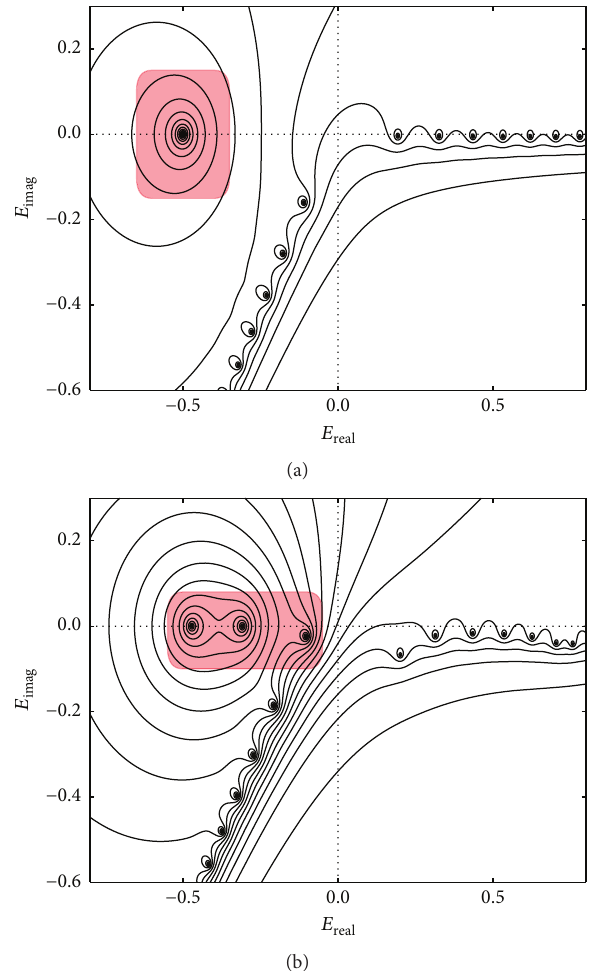
Figure 2: Outgoing resonance eigenvalue equation landscapes for Dirac-delta ((a) 𝐵 = 1 ) and square-well potential ((b) 𝑑 = 4 and = −0.5 ) systems in the external field 𝐹 = 0.03 . To visualize the 𝑉 0 locations of the energy eigenvalues, we evaluate (14) and (15) over a range of 𝐸 in the complex plane and convert |𝐷| to a height map via the formula (1−(1+|𝐷| 0.3 ) −1 +𝜖) −1 , so that its roots are represented by poles that are easy to locate ( 𝜖 ≈ 0.1